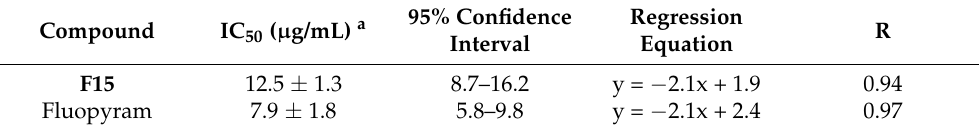
Table 5. In vitro IC 50 values of the compound F15 and fluopyram against S. sclerotiorum